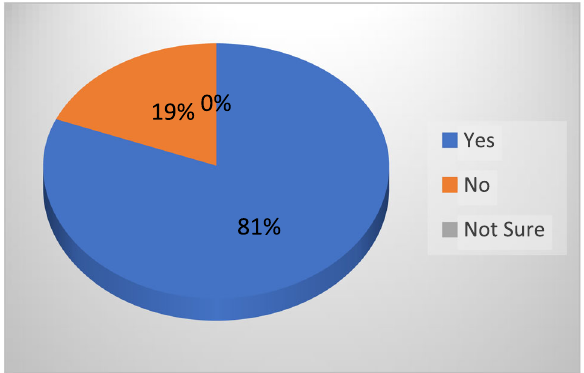
Fig. 4 Separation and duplication compromise the effective use of resources in disaster risk reduction and climate change adaptation. Source Online survey of respondents in the Southern African Development Community study ( N =